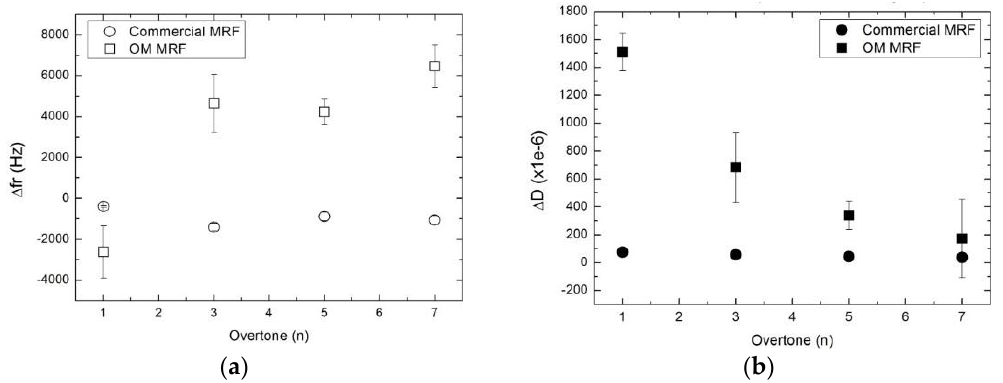
Figure 7. ( a ) Frequency shift (open) and ( b ) change in dissipation (solid) as function on the overtone at the end of the region II. Values shown are referenced to the end of the region I.